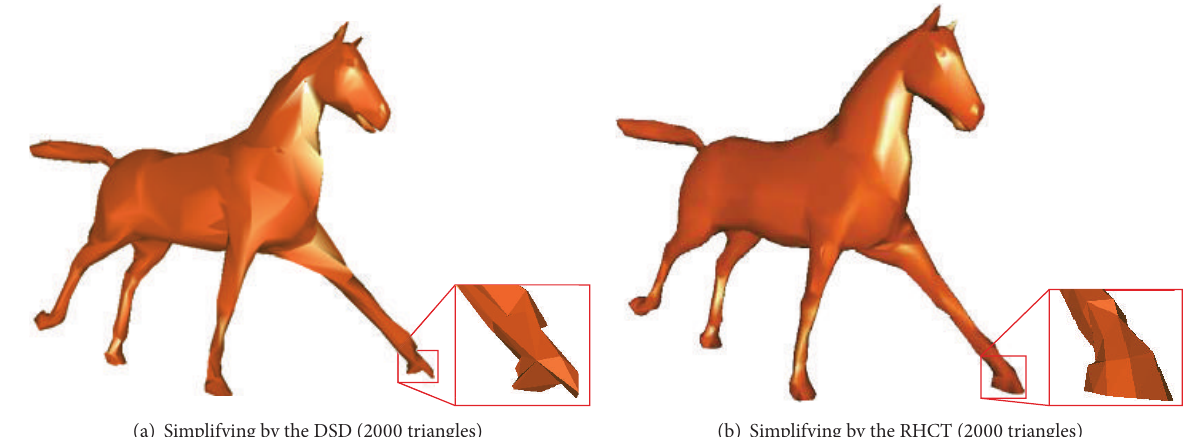
Figure 8: The shape of horse hoof is destroyed gradually when simplifying by the DSD.